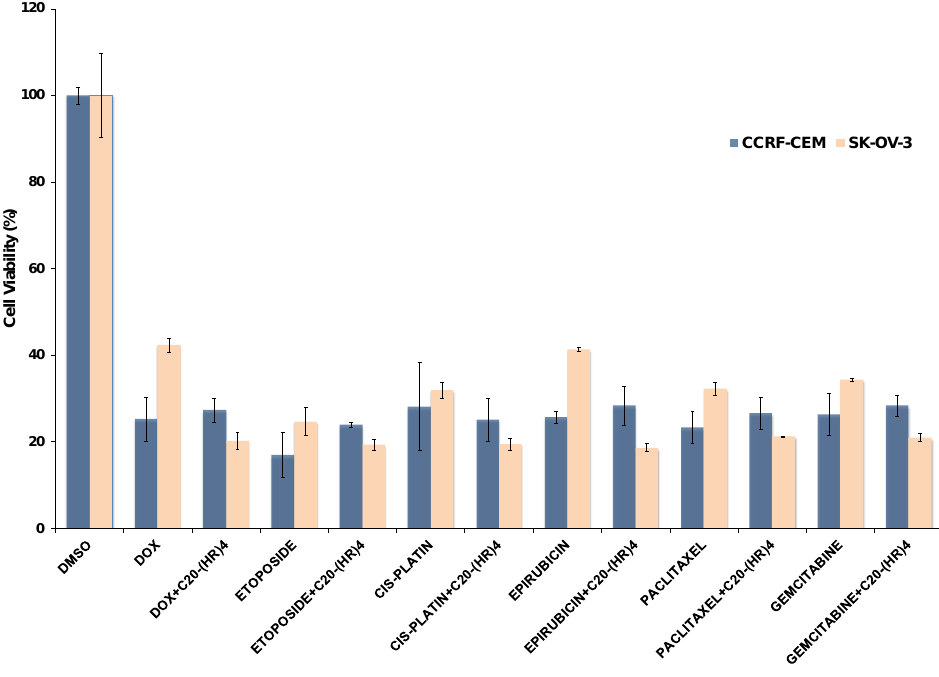
Figure 9. Anti-proliferative assay results for C 20 -(HR) 4 with different anticancer drugs.